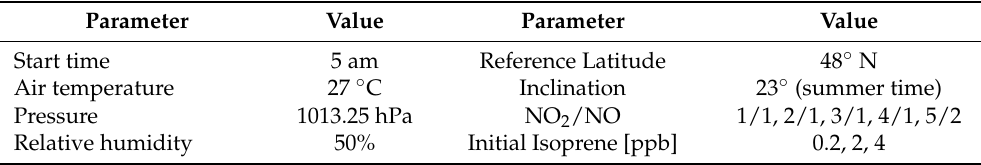
Table 1. Initial conditions for the box model